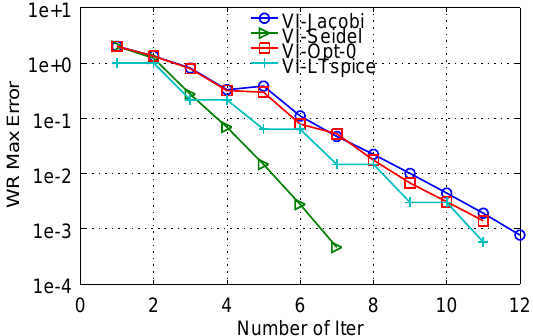
Figure 9: The WR error as function of the number of itera- tions: case of the more resistive load